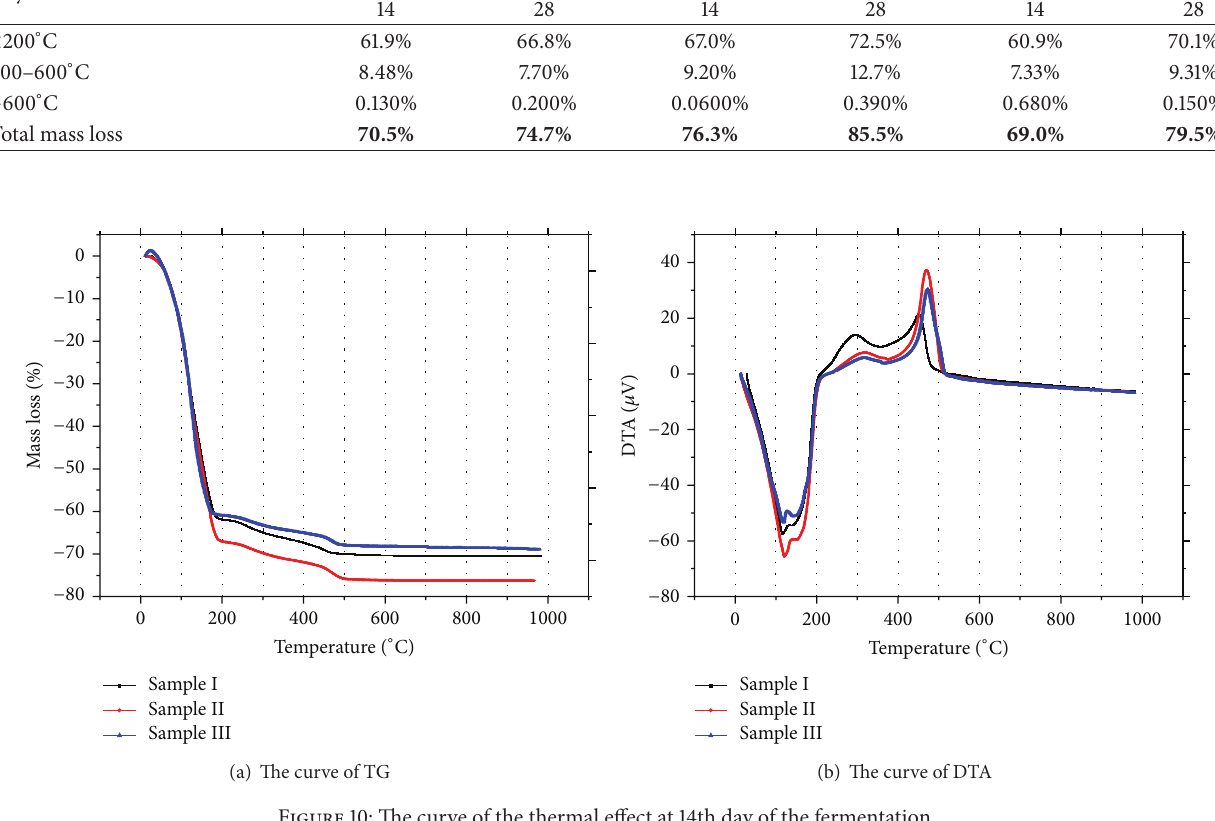
Figure 10: The curve of the thermal effect at 14th day of the fermentation.